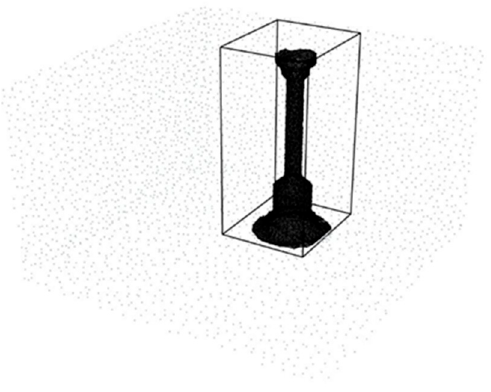
Figure 8. Volumetric subset surface reconstruction.